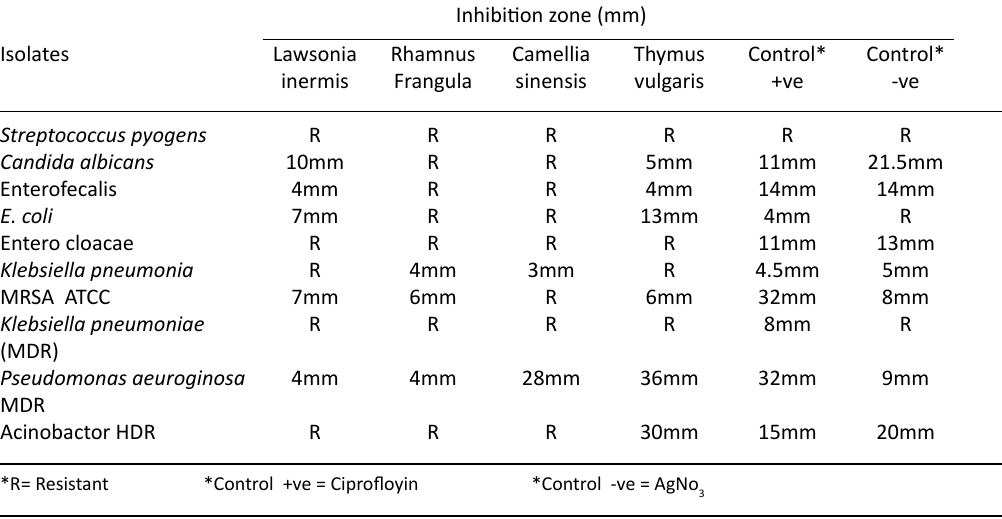
Table 1. Antimicrobial activity of La, Rh, Ca and Th silver nanoparticles